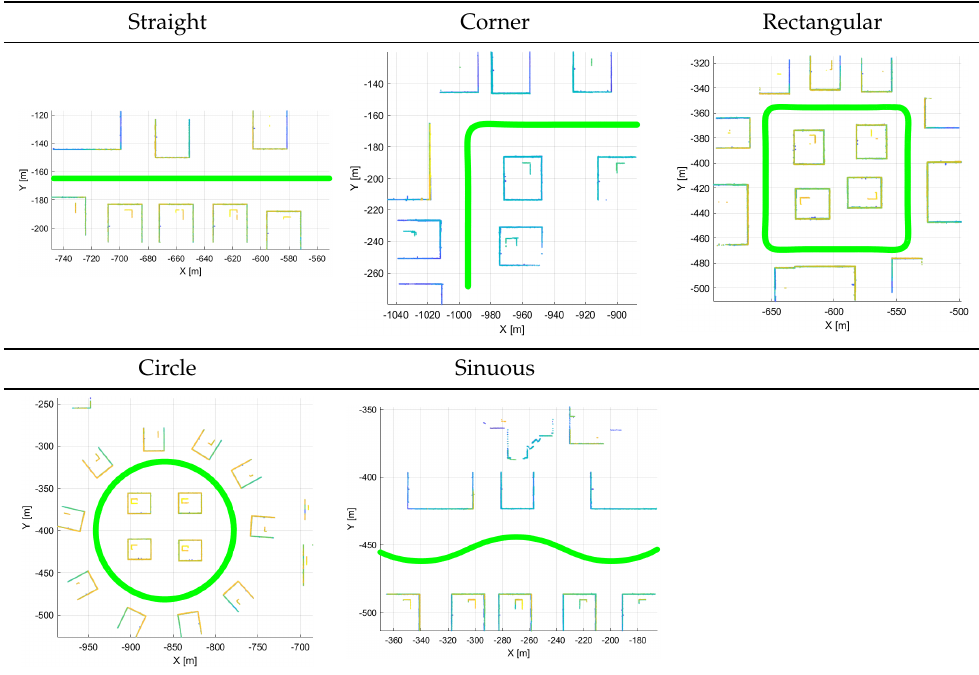
Table 3. Various environments for experiments using simulation data. Green lines represent trajecto- ries of vehicle. Rectangular boxes represent buildings from which point cloud can be